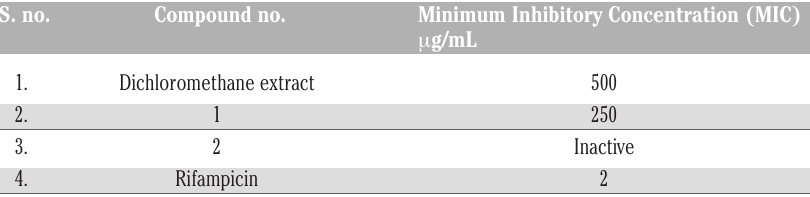
Table 2. Antimycobacterial activity of compounds and extract against M. tuberculosis H37Rv. S.